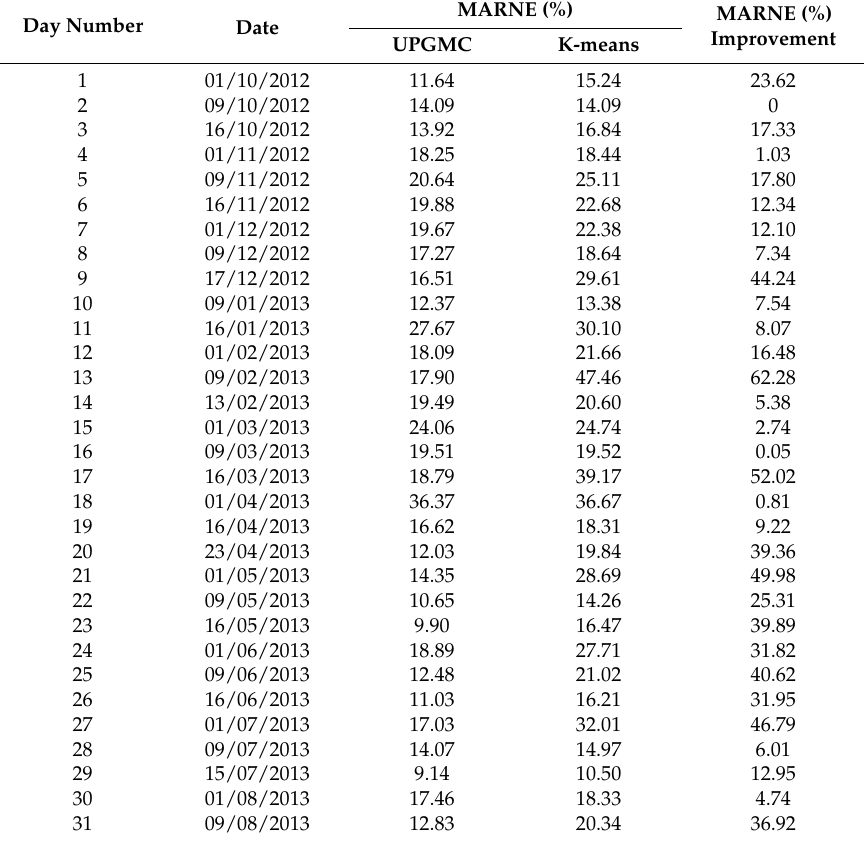
Table 4. Comparison of the K-means and the UPGMC algorithms in terms of missing data completion